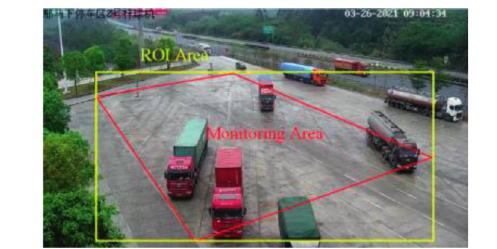
Figure 8: ROI area divide.